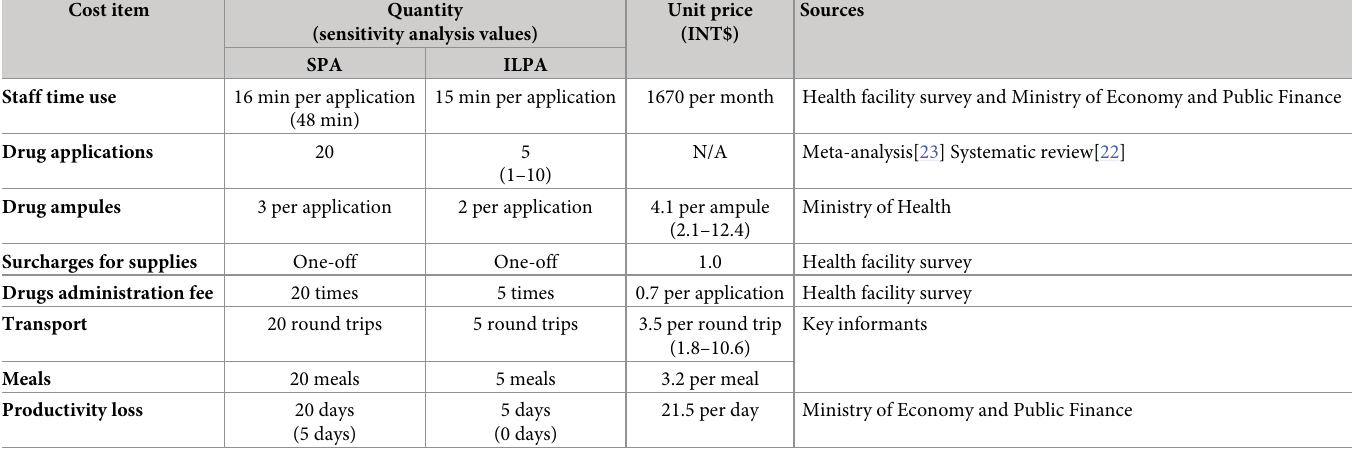
Table 1. Resource use quantities and unit prices (in